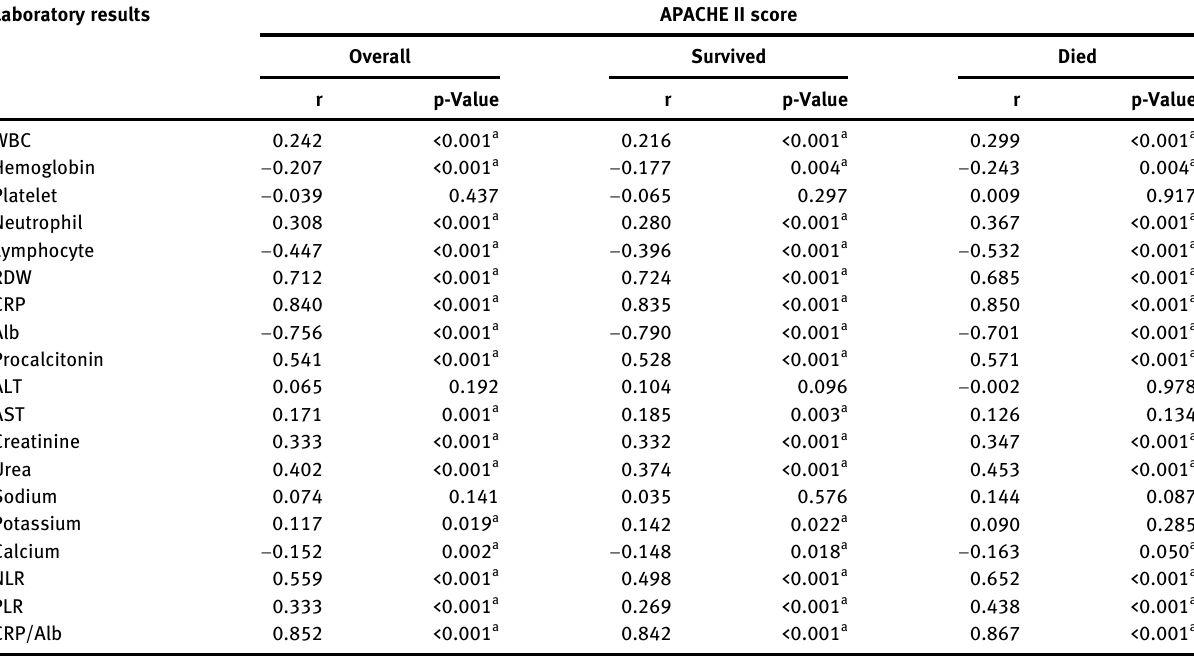
Table  : Laboratory fi ndings according to the APACHE II score. Laboratory